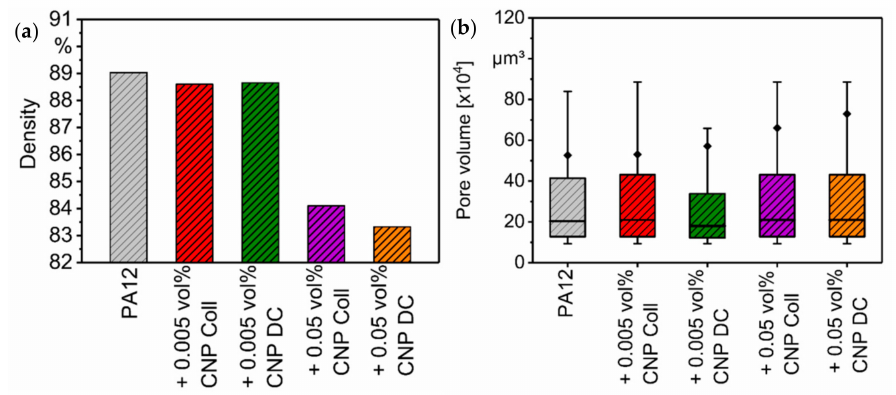
Figure 11. ( a ) Relative density and ( b ) pore size distribution of pure PA12 and PA12 specimens with CNP additivation.